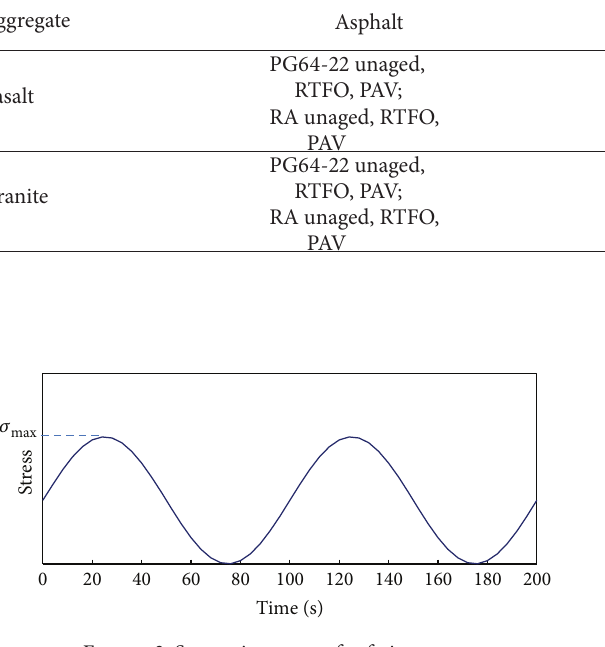
Figure 3: Stress-time curve for fatigue test.